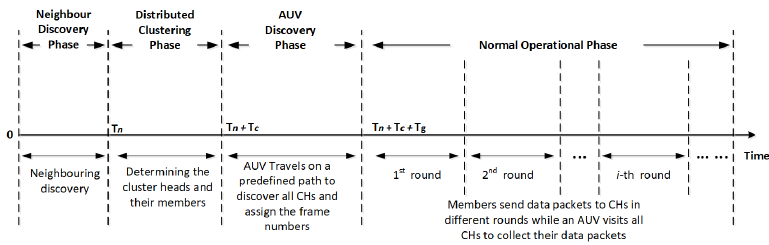
Figure 1. Timeline of Cross-Layer Mobile Data gathering (CLMD)